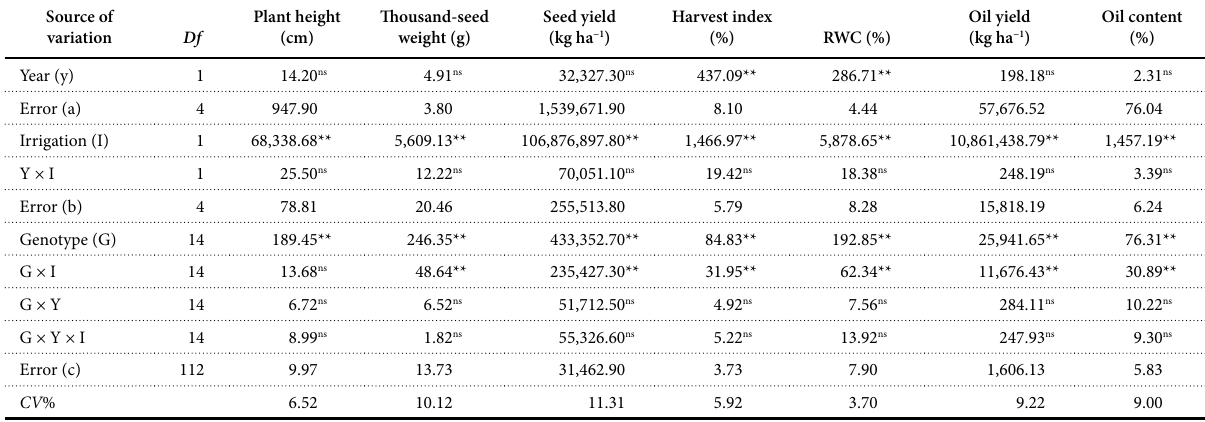
Tab. 2 Combined analysis of variance indices of 15 safflower genotypes grown under normal irrigation and water deficit stress conditions in growing seasons of 2016 and